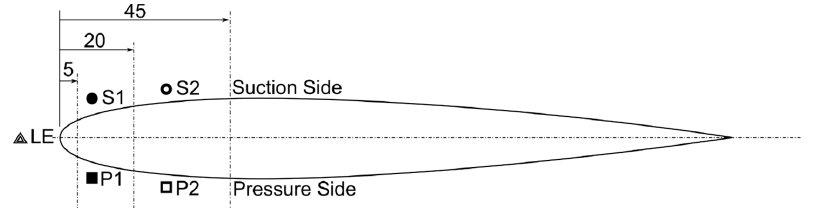
Figure 3. Diagram of the NACA 0012 support with 180 mm-chord length and labels for positions on